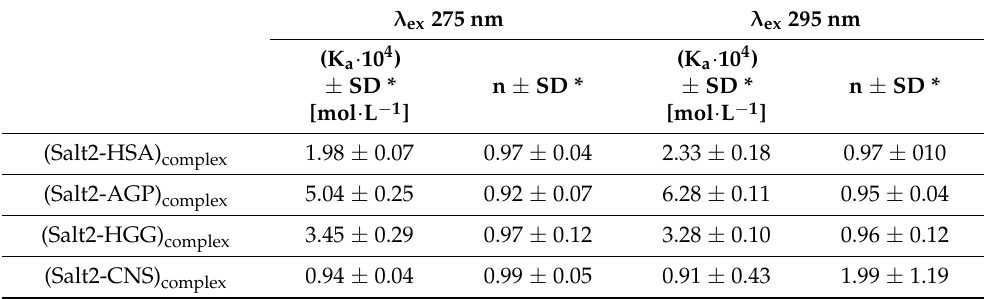
Figure 5. The Klotz plots for ( a ) Salt2-HSA; λ ex 275 nm, λ ex 295, ( b ) Salt2-AGP; λ ex 275 nm, λ ex 295, ( c ) Table 5. The binding parameters for Salt2-HSA, Salt2-AGP, Salt2-HGG and Salt2-CNS complex. λ ex 275